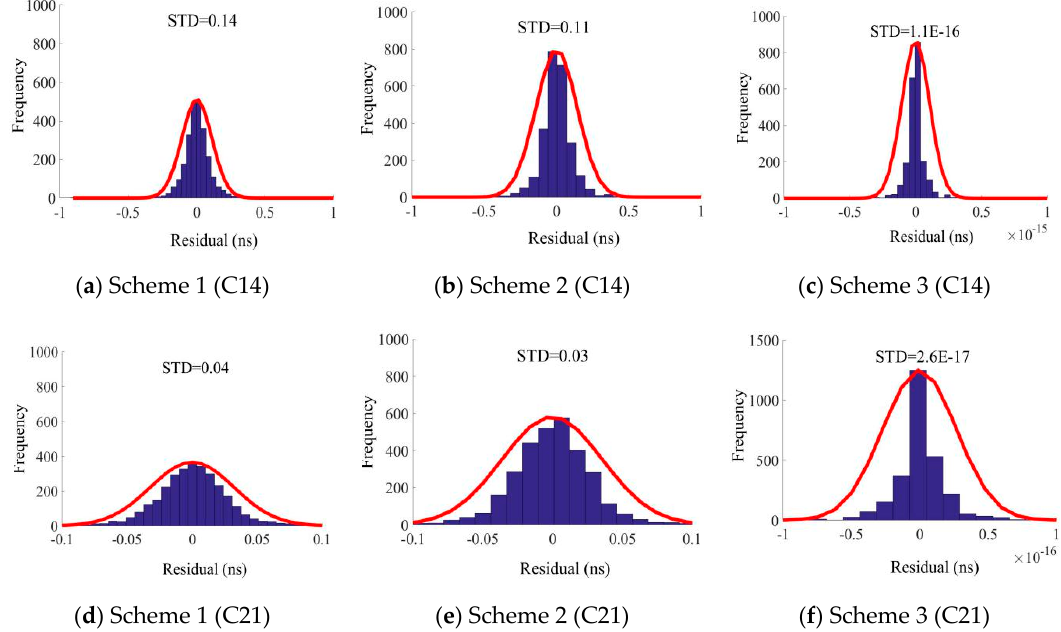
Figure 7. Histogram of the residuals of the C14 and C21 satellites resulting from three schemes the period of 31 during the period of 31 days.